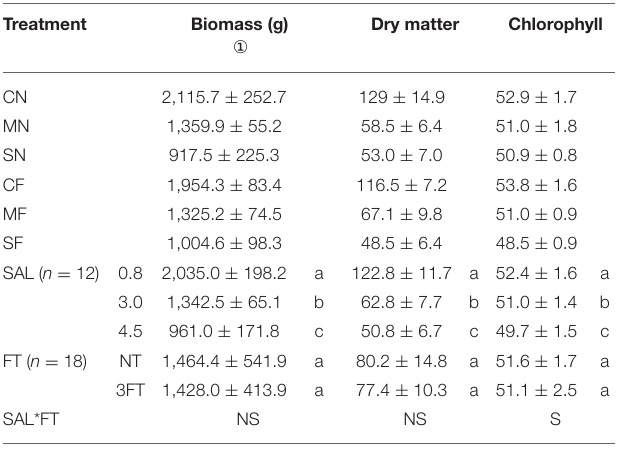
TABLE 2 | Combined treatment on biomass, dry matter, and leaf chlorophyll (SPAD value).